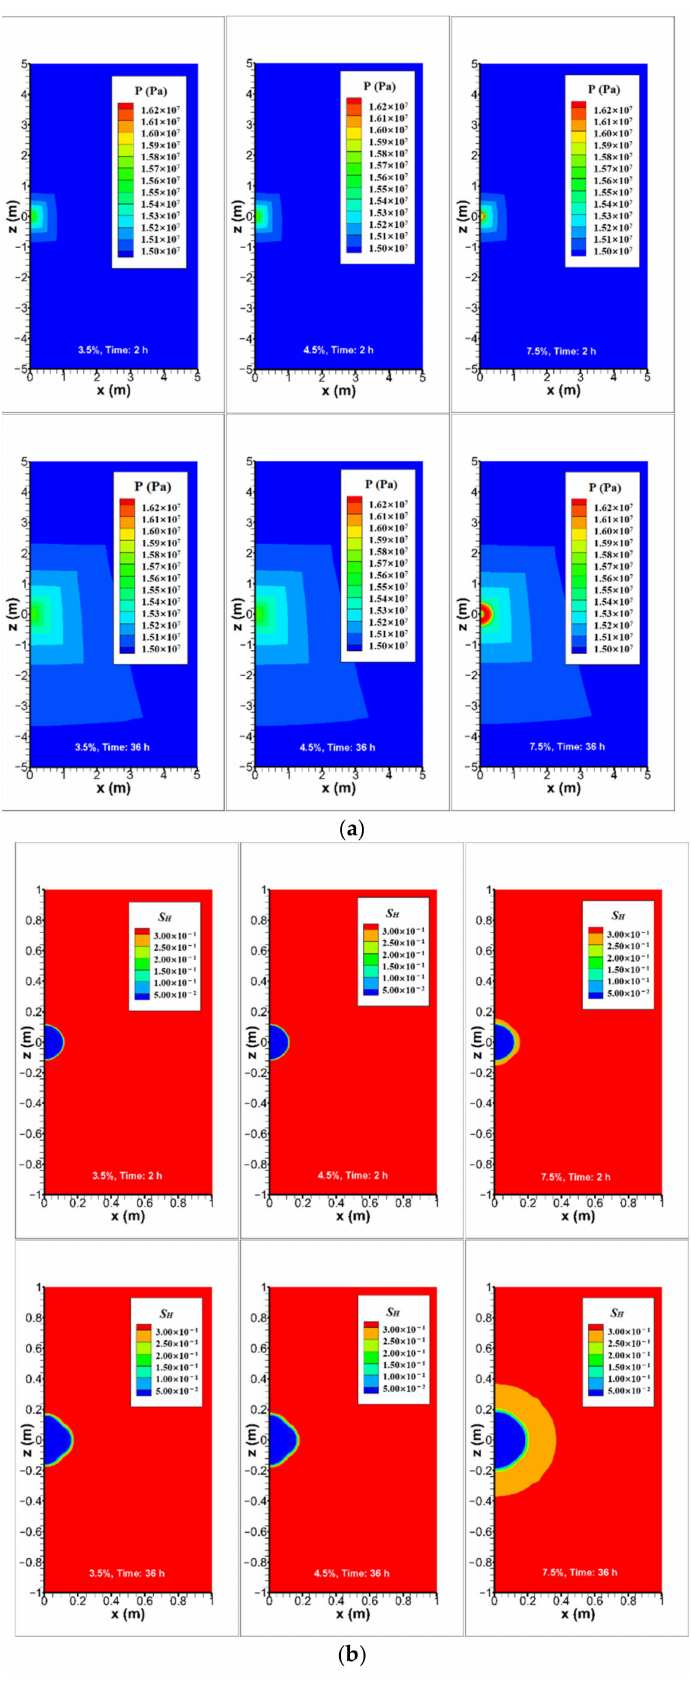
Figure 10. The Pore pressure and NGH saturation distribution evolution of the near-wellbore. ( a ). Pore pressure distribution around the wellbore; ( b ) NGH saturation distribution around the